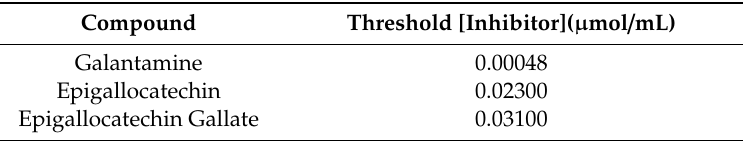
Table 6. Threshold concentrations required for AChE inhibition.